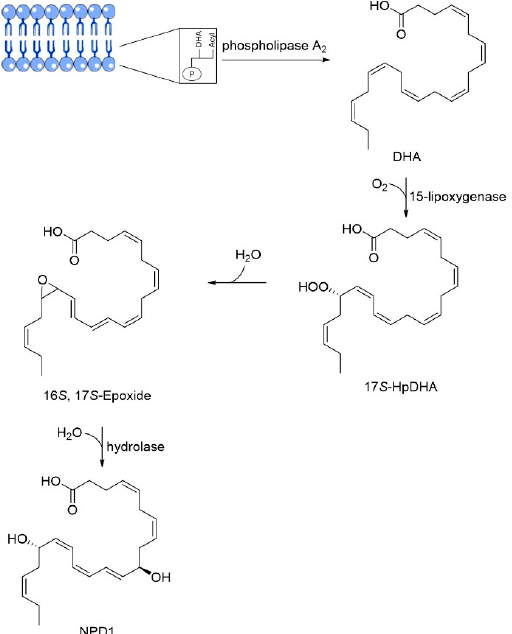
Figure 6. Biosynthesis of neuroprotectin D1 (NPD1). Phospholipase A2 releases docosahexaenoic acid (DHA) from membrane phospholipids and 15-lipoxygenase catalyzes the deoxygenation at C17, followed by the formation of an epoxide that is enzymatically hydrolyzed in NPD1. Adapted from [77]